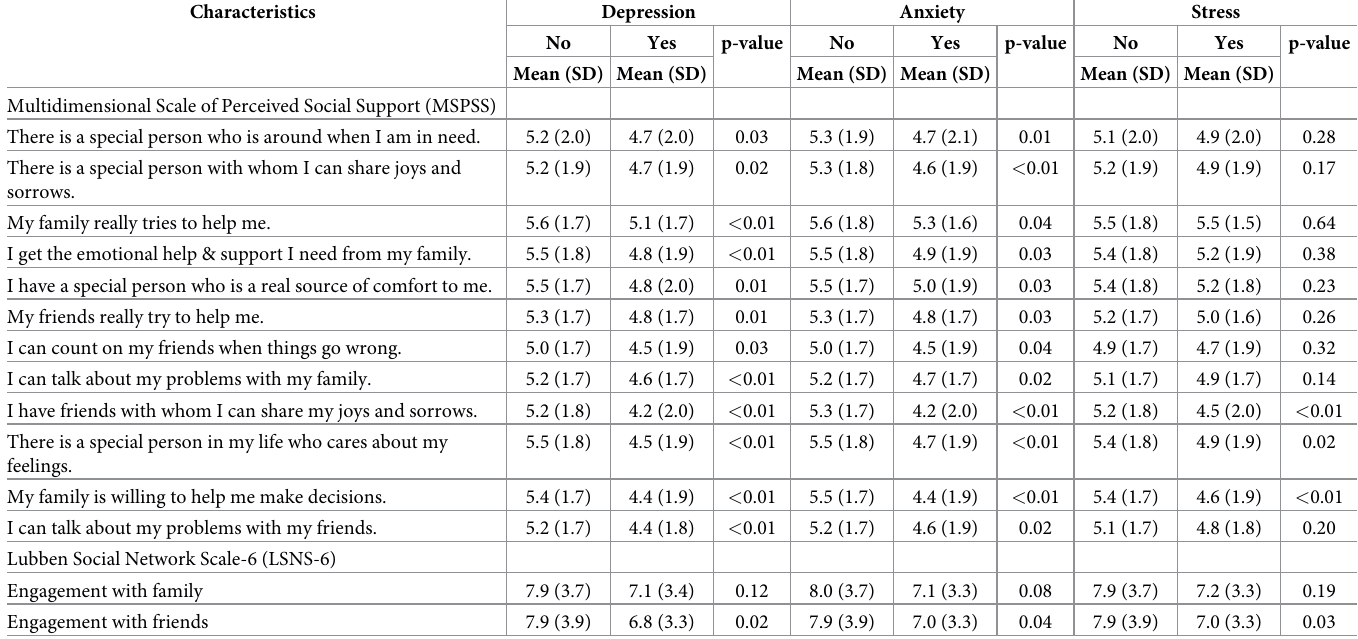
Table 3. Structural and functional supports regarding depression, anxiety, and stress (n = 236).